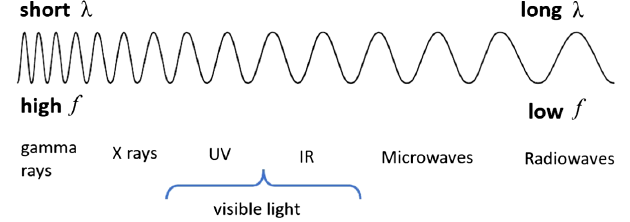
FIG. 12. Schematic representation of the EM spectrum com- monly found in